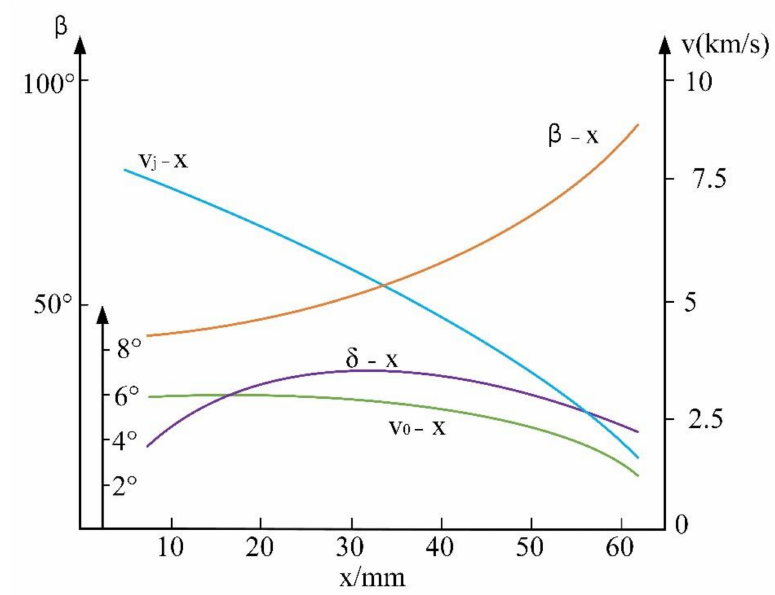
Figure 14. Distribution of the main parameters in the jet formation